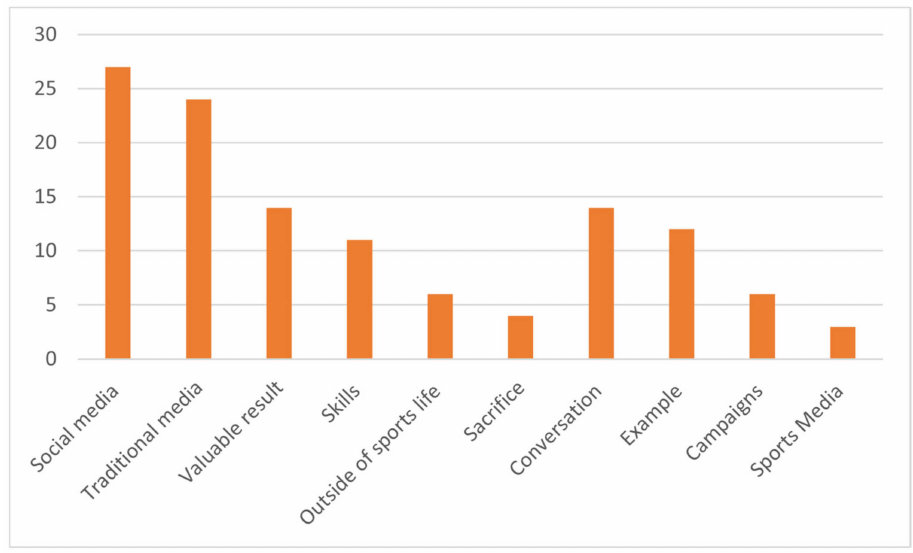
Figure 4. Distribution of specifications for the “media tools”